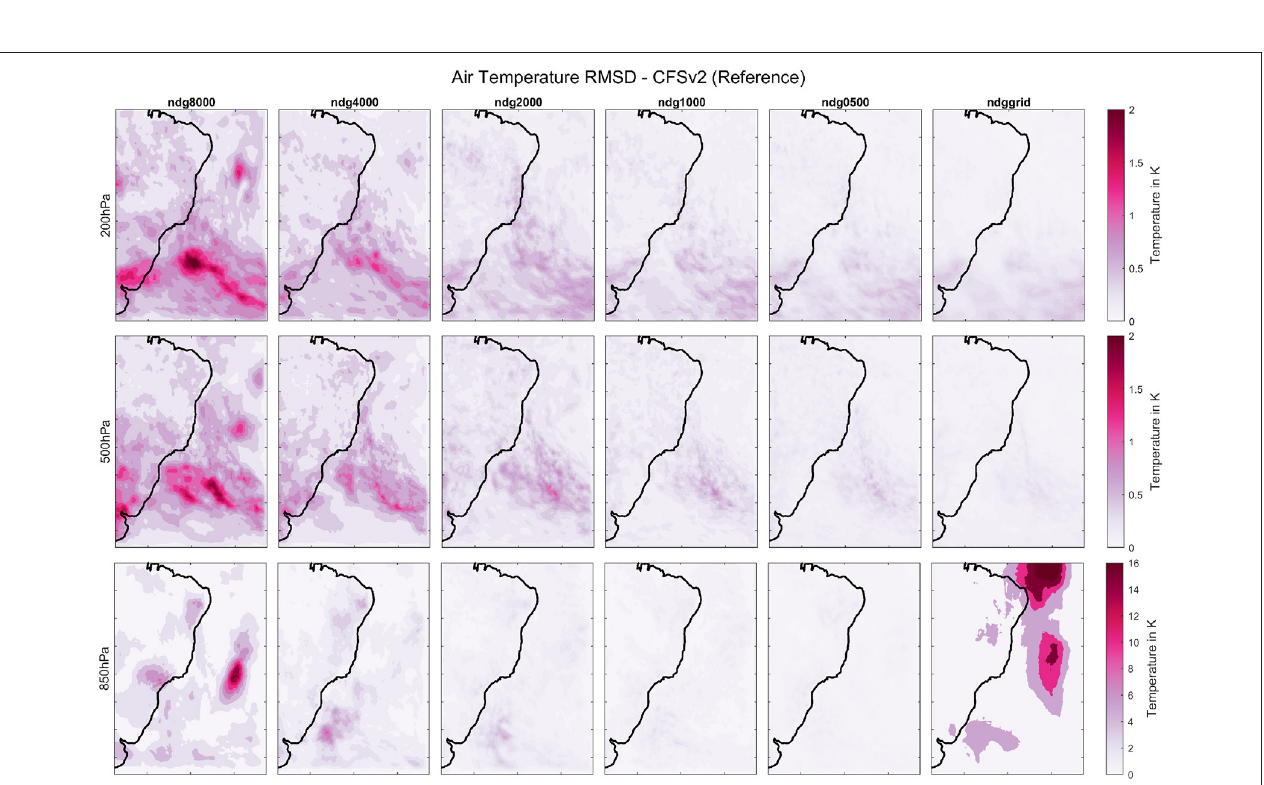
FIGURE 5 | RMSD of temperature values during the SACZ event. Maps of all numerical experiments (columns) for upper levels (200 hPa, top row), middle levels (500 hPa, middle row) and lower levels (850 hPa, bottom row) are shown.